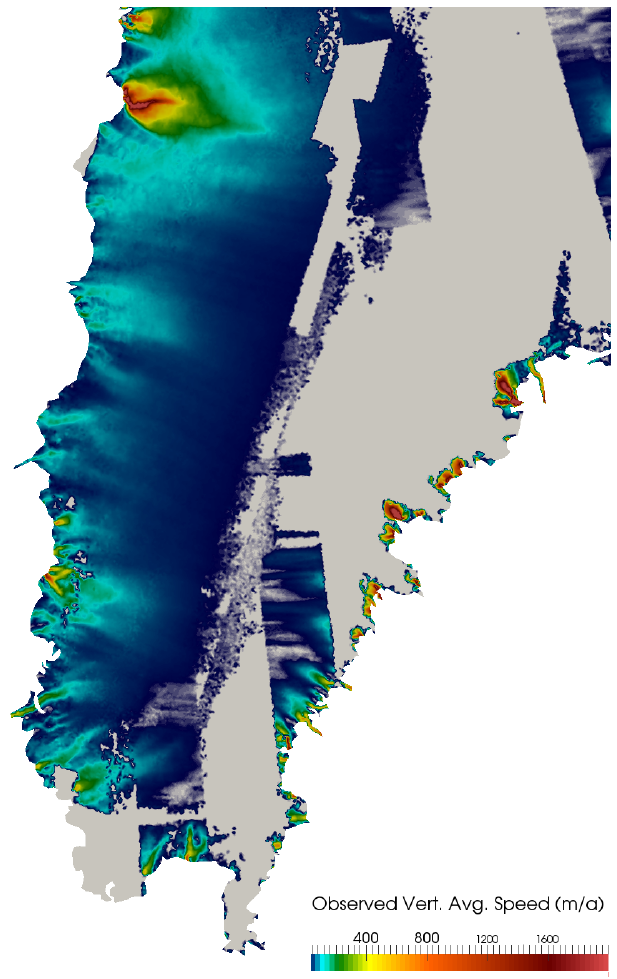
Figure 4. Final surface speeds, computed through the optimization of the speed constrained by the continuity equation described in this